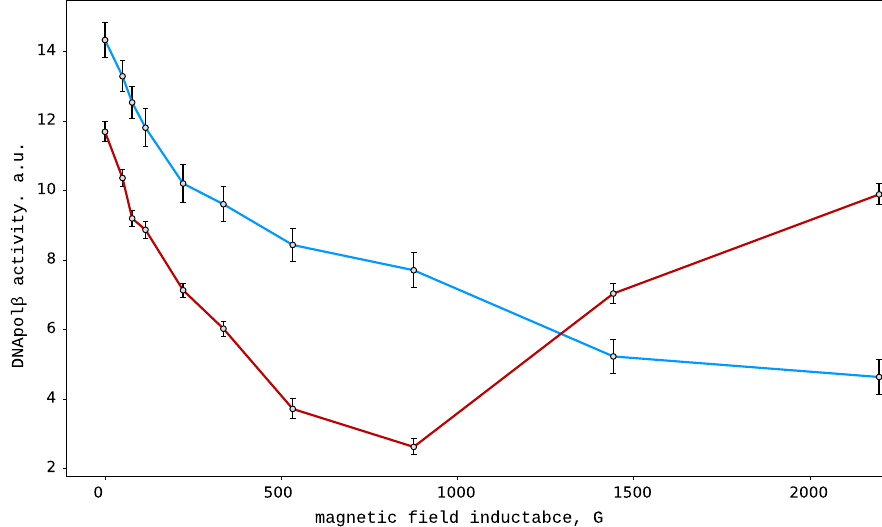
Figure 1. Catalytic activity of DNApol β as a function of the external magnetic field induction. The blue curve corresponds to the samples loaded with the non-magnetic 24 Mg 2 + , while the red one – to the samples containing only magnetic magnesium isotope ( 25 Mg 2 + ). The error bars reflect the standard deviation calculated over three independent